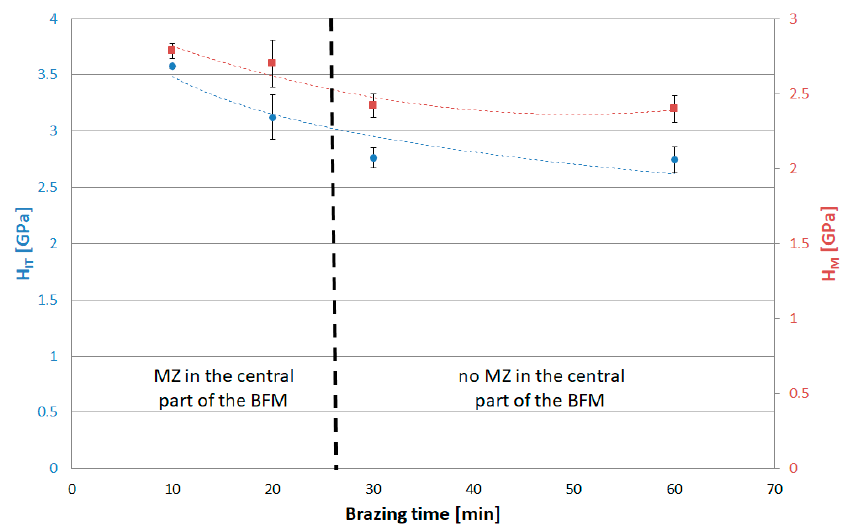
Figure 16. Indentation hardness and Martens hardness for Hastelloy X–Palnicro 36M joints by 1 N load.